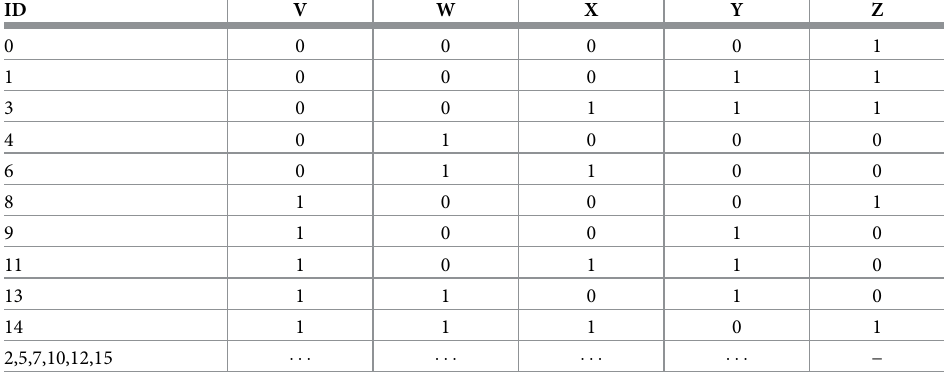
Table 1. Function